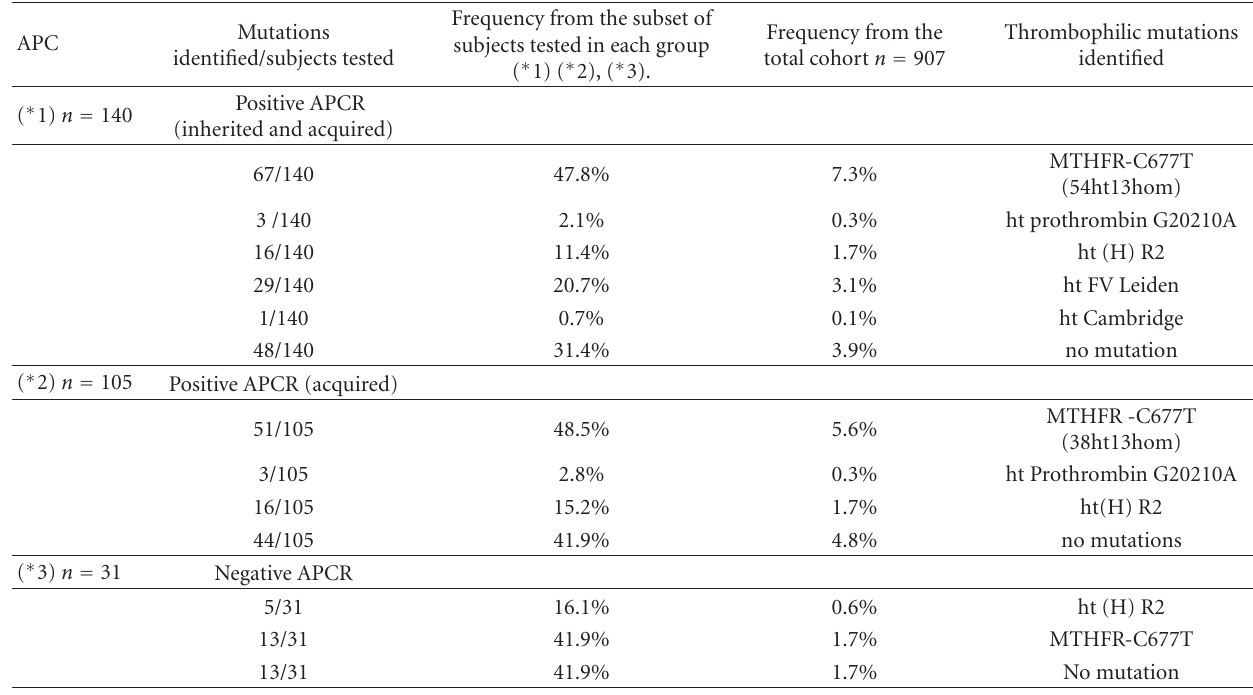
Table 3: Distribution of the thrombophilic mutations identified in our study cohort.